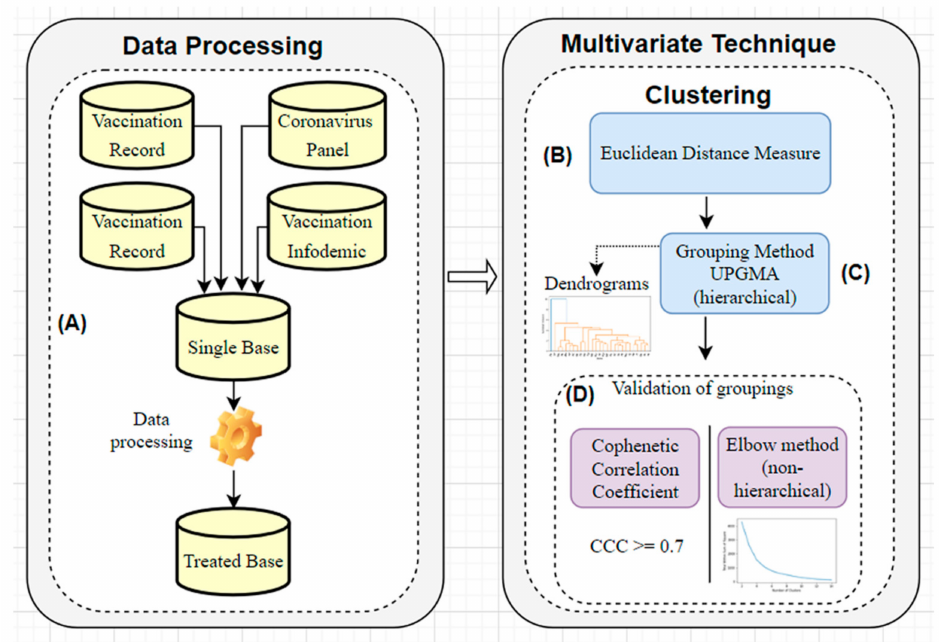
Figure 1. Flowchart of the methodology of the multivariate technique adopted. Processing the data: ( A ) selection and treatment of variables. Multivariate Technique: ( B ) selection of the distance measure; ( C ) selection of the clustering algorithm and ( D ) validation of the